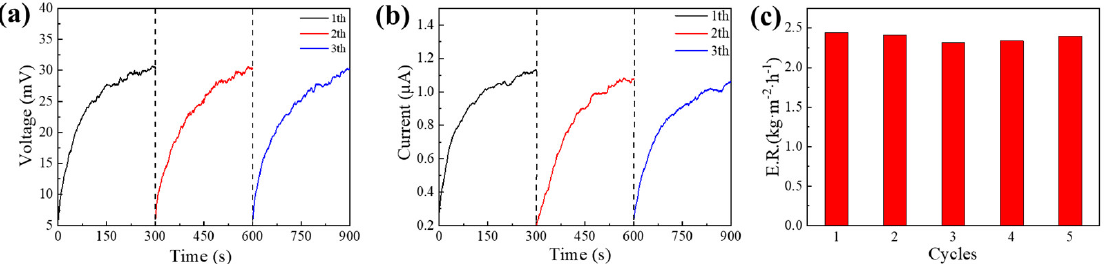
Figure 9. Cycling stability of the device G/ZnO@G/BN. ( a ) Open−circuit voltage; ( b ) Short−circuit current; ( c ) evaporation rates.